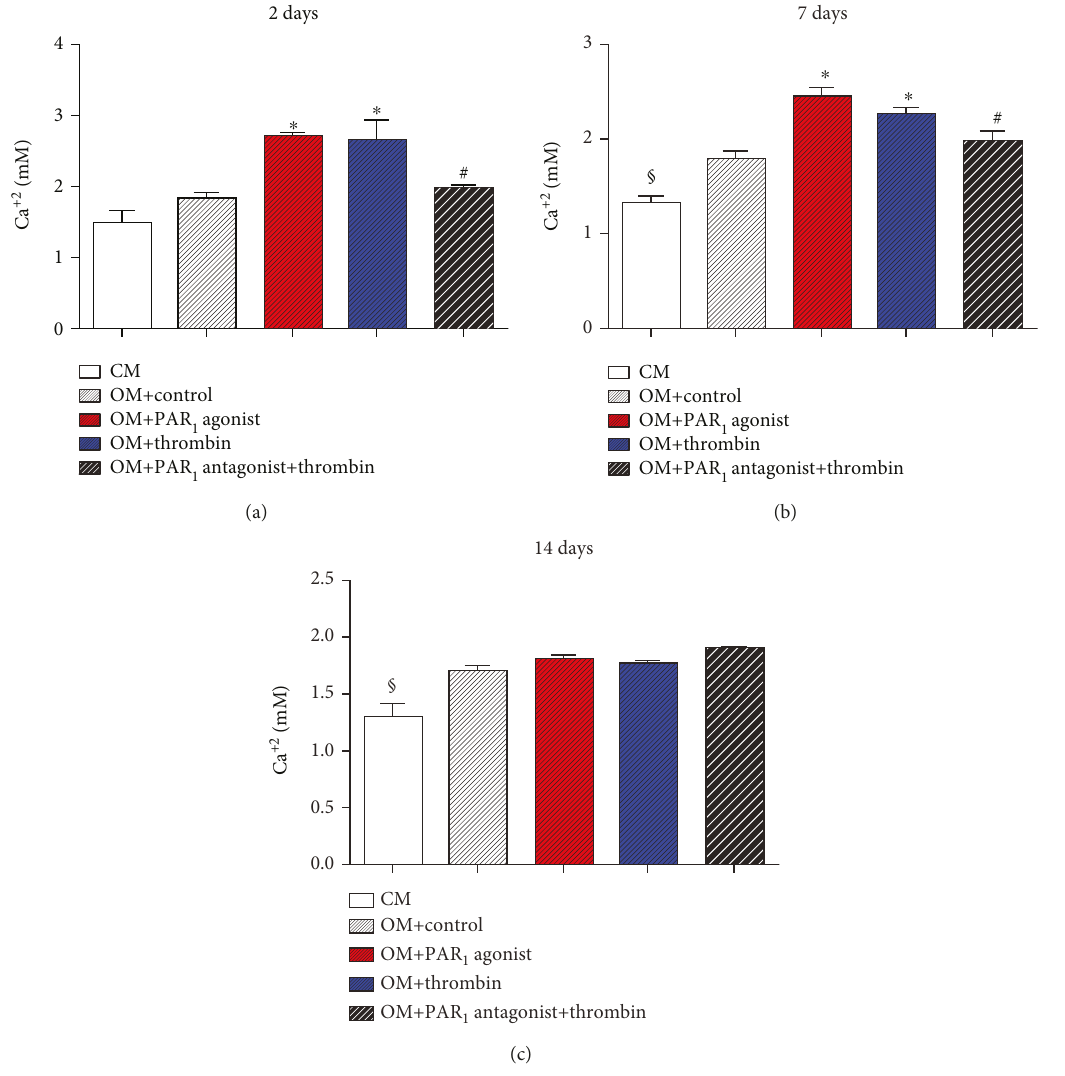
Figure 4: Calcium concentration in the supernatant in di ff erent groups. Values are presented as mean and SEM; n = 3 . ∗ Mean signi fi cant di ff erence when compared to OM + control ( p < 0 05 ). # Mean signi fi cant di ff erence when compared to OM + thrombin ( p < 0 05 ). § Mean signi fi cant di ff erence when compared to OM groups ( p < 0 05